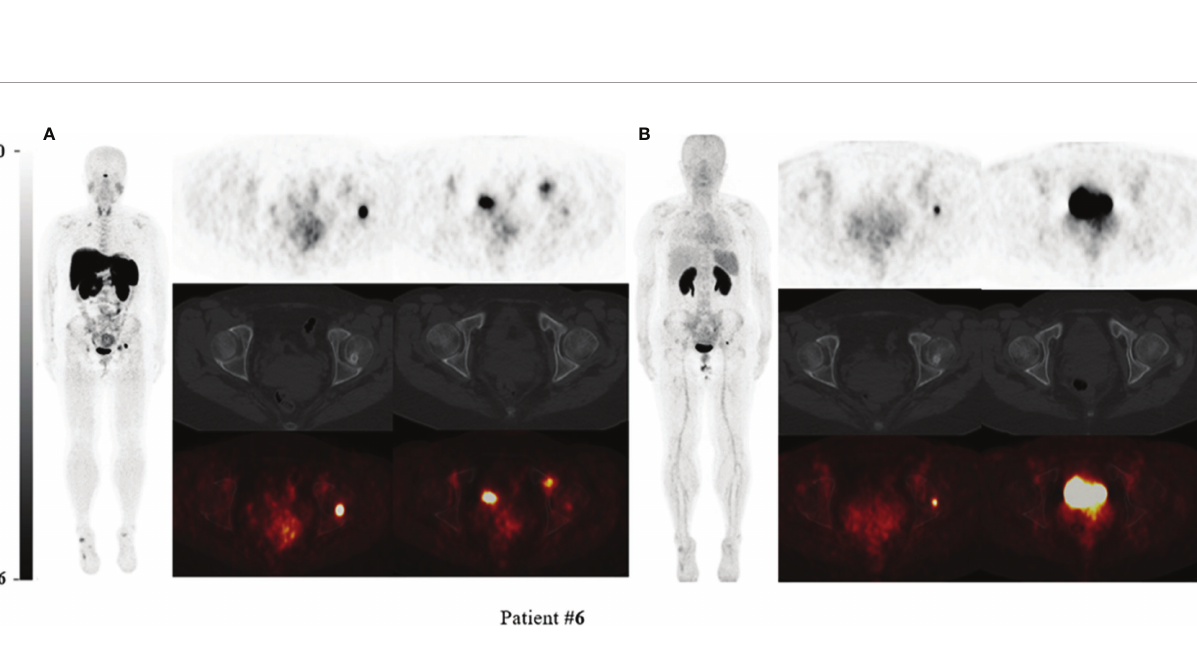
FIGURE 2 | 68 Ga-DOTA-TATE PET/CT compared with 68 Ga-DOTA-JR11 PET/CT in Patient #6 with multiple suspected lesions. Two intensive uptake lesions in the left femoral head and left pubic bone revealed on 68 Ga-DOTA-TATE PET/CT (A) , which suggested that they might be the culprit tumors. The lesion of the left femoral head showed osteogenic change. However, the lesion in the left pubic bone only showed slightly increased uptake and the focus in the left femoral head still showed high uptake on 68 Ga-DOTA-JR11 PET/CT (B) . The lesion of the left femoral head was con fi rmed as the responsible tumor of TIO by postsurgical pathological